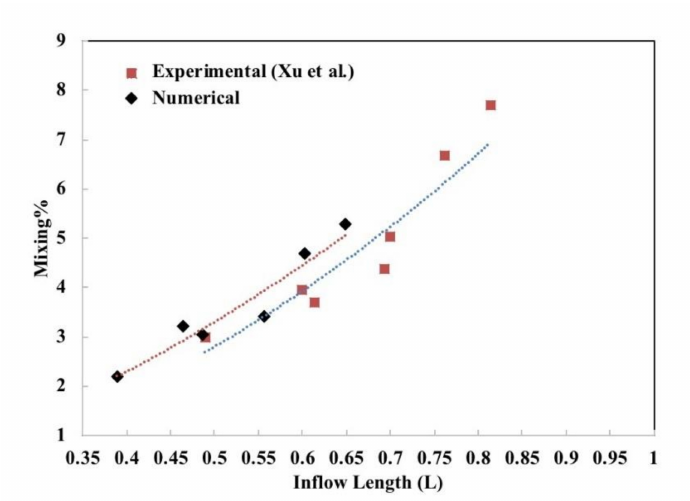
Figure 3. Percent mixing as a function of the dimensionless inflow length for the experimental and numerical